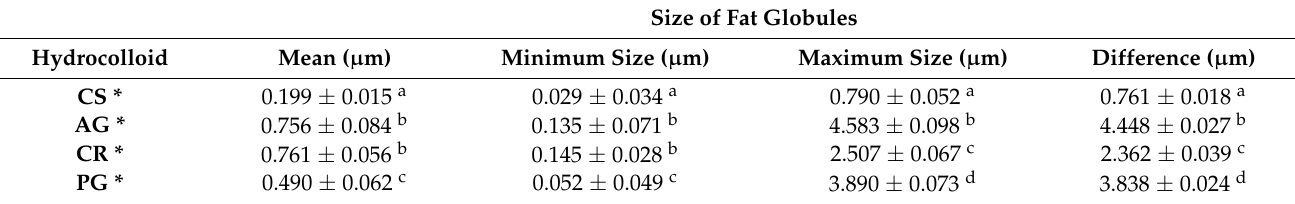
Figure 5. Scanning electron microscopy images of the model processed cheese (the scale bars represent 10 µ m; 1000 × magnification). ( A ) Sample with emulsifying salts; ( B ) sample with agar; ( C ) sample with κ -carrageenan; ( D ) sample with gelatin; FG* (and white arrows)—void space of fat globules; P—protein structure; PPS—protein-polysaccharide structure. Table 3. Size (diameter) of fat globules of the model processed cheese samples; the results are expressed as mean ± standard